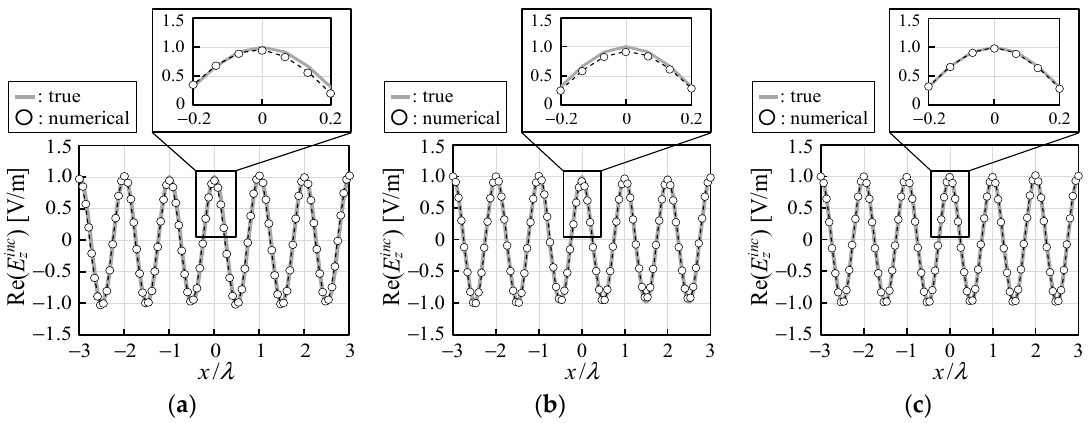
Figure 6. Distributions of incident field on x -axis (target is cylinder): ( a ) M = 51, ( b ) M = 100, and ( c ) M = 200.